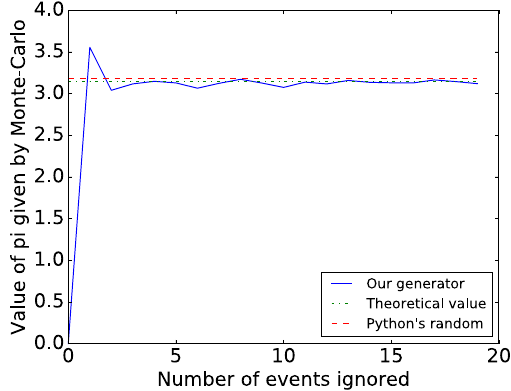
Fig. 5. Results of the Monte-Carlo method for the calculation of p using the durations d n and d n + k , where k is the number of ignored events, for the determination of each